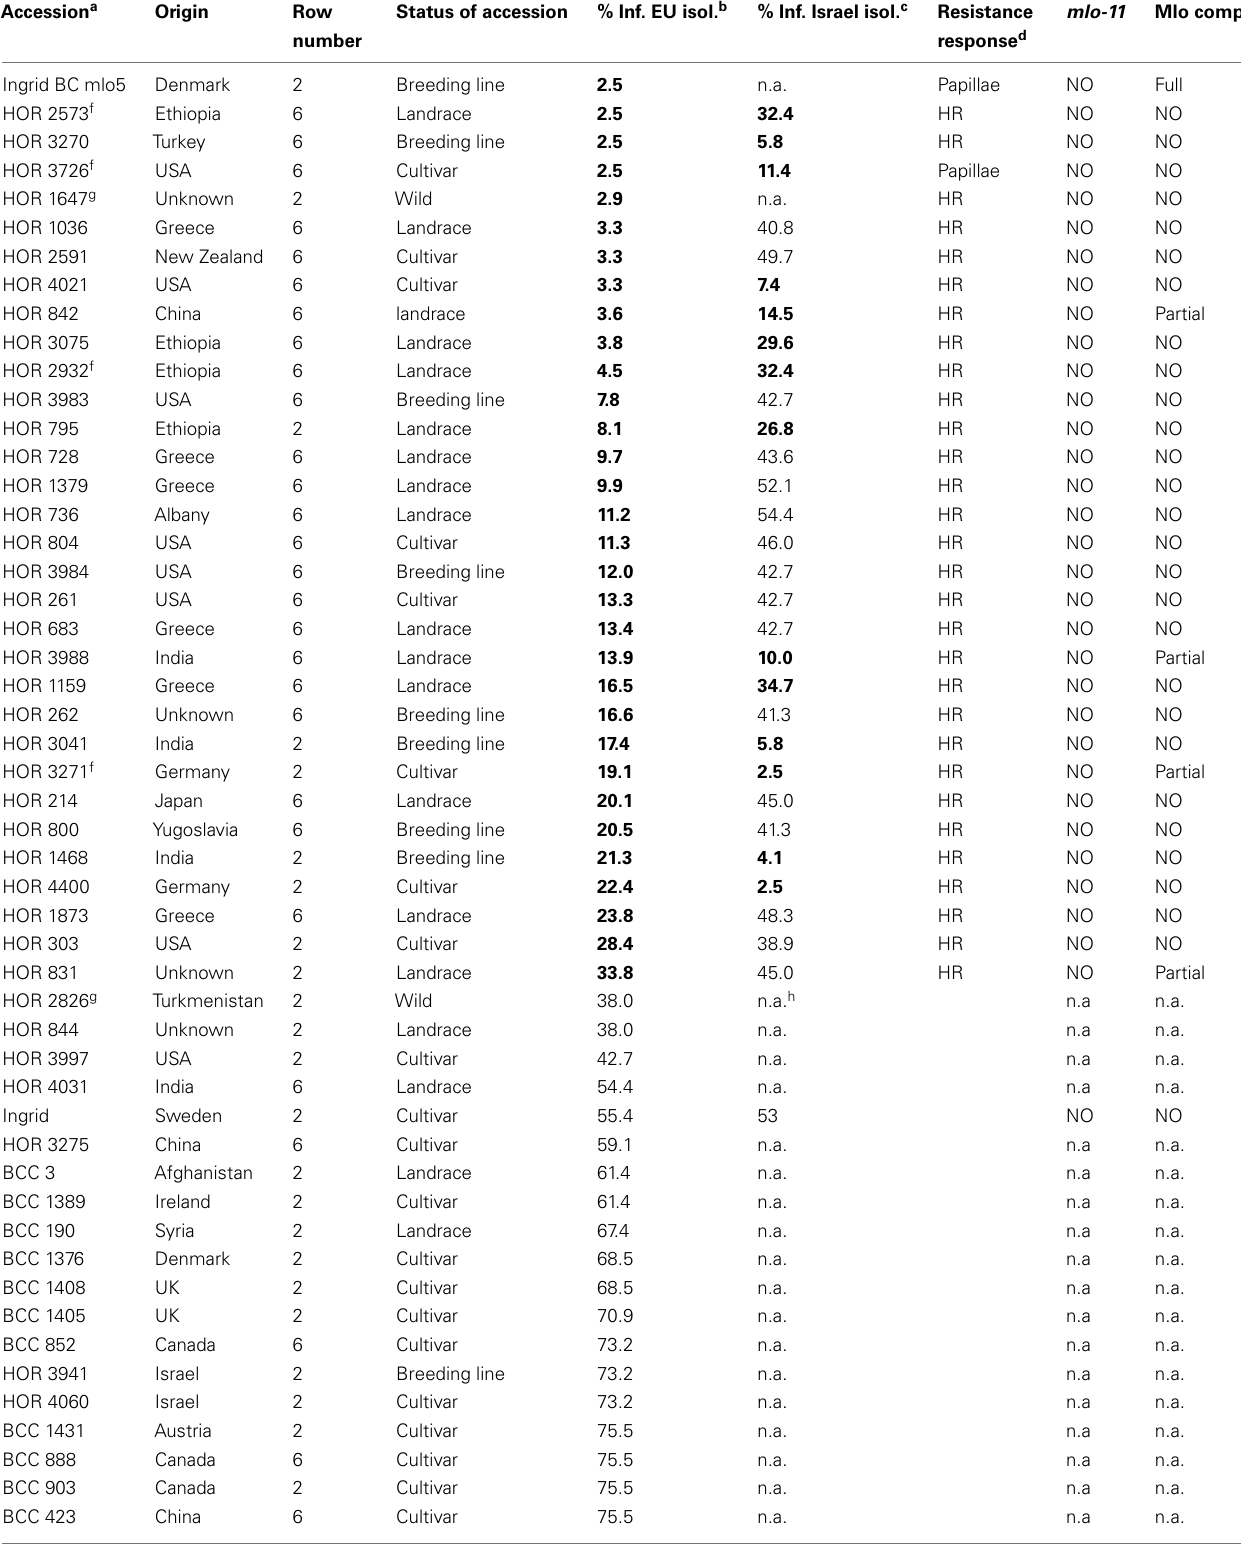
Table 1 | Characterization of the customized barley collection for race-non-specific resistance to Bgh